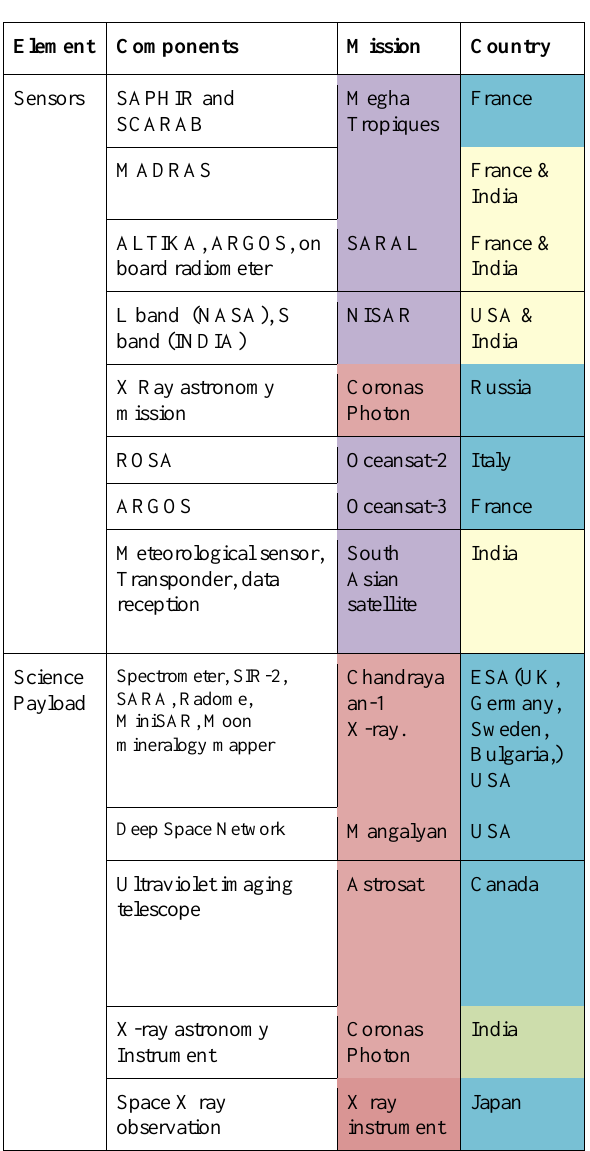
Table 2. Collaborations for development / contributions of Payload / Sensors Most common International cooperation happens in the form of MOU in telemetry and tracking where restricted ground access in other countries becomes accessible for tracking